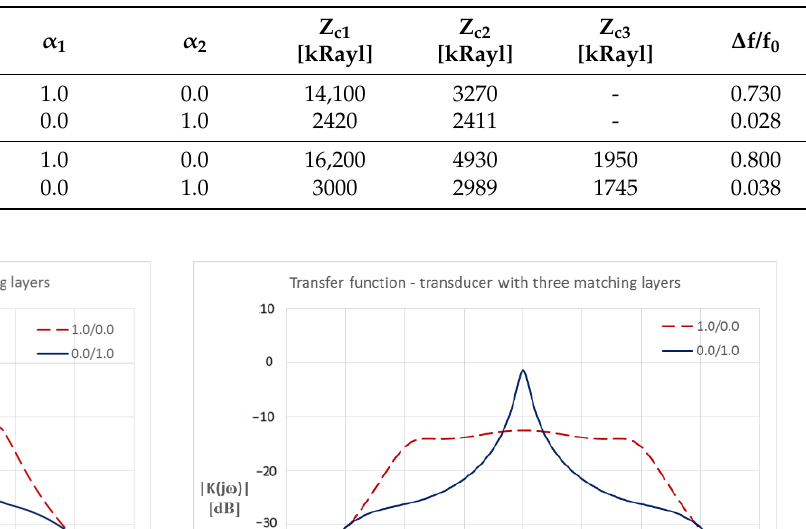
Table 2. Acoustic impedances of the matching layers obtained with the genetic algorithm (water, Z T = 1500 kRayl, the impact of α 1 and α 2 coefficients).